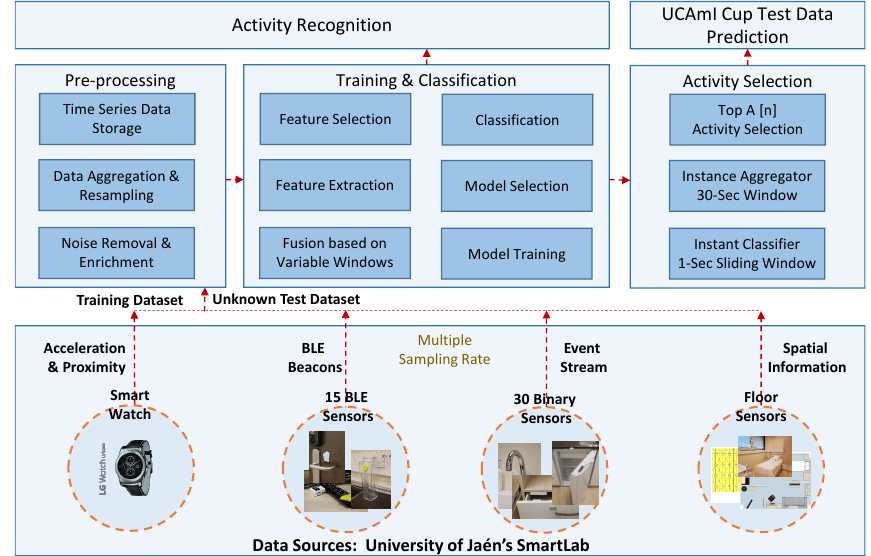
Figure 1. Proposed framework for Activity recognition using UJAmI Smart Lab